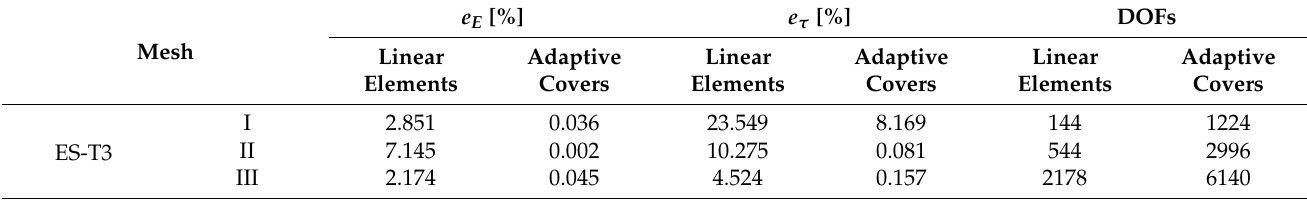
Table 3. Relative errors (%) in the energy norm ( E ) and the maximum von Mises stress ( τ ) in the ad hoc problem. e E [%] e τ [%] DOFs Mesh